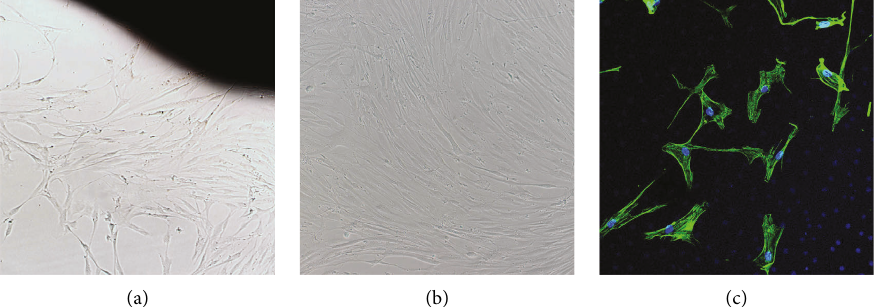
Figure 1: The morphology of ASMCs and ɑ -actin immunohistochemical staining were observed under an inverted microscope. (a) ASMCs grew at the edge of the tissue patch after 3–5 days of tissue patch culture. (b) ASMCs grew and merged into a “peak valley” shape. (c) Immunohistochemical staining of α